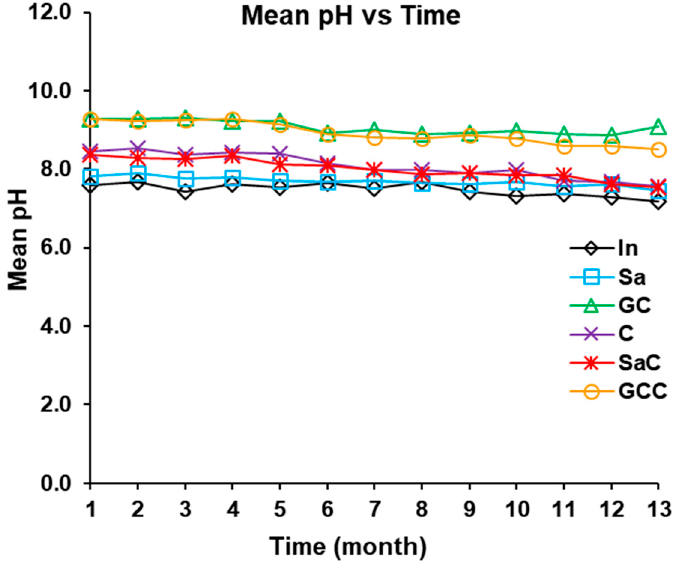
Figure 2. Mean pH change with time for the entire study duration (In, inlet; Sa, sand; GC, gas concrete; C, biochar; SaC, sand + biochar; GCC, as concrete + biochar).